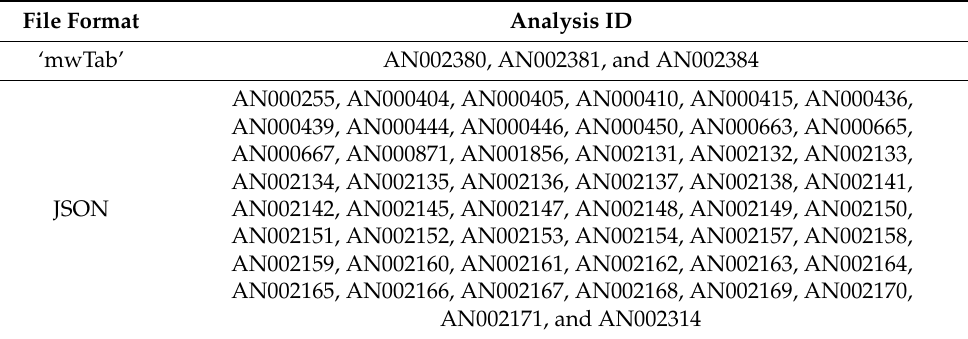
Table 3. List of analysis IDs and the format of files that could not be downloaded through Metabolomics Workbench’s REST